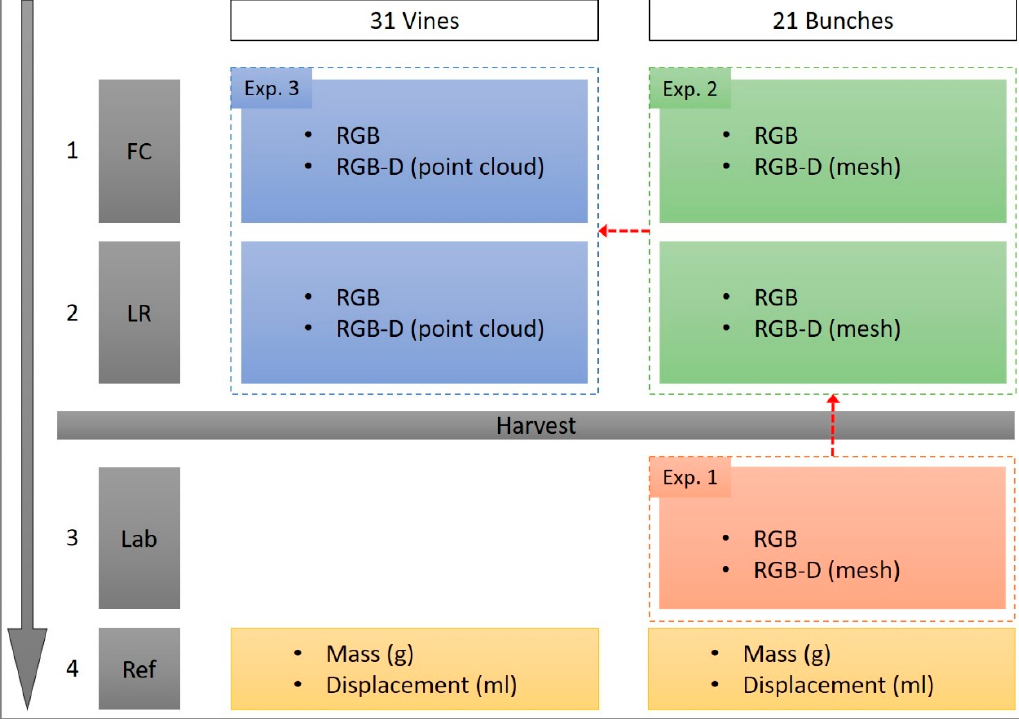
Figure 2. Data-acquisition protocol used in this study. Order of acquisition indicated by the grey arrow. {Key: FC = full canopy; LR = leaf removal; Lab = laboratory; Ref = reference measurements; Exp = experiment}.